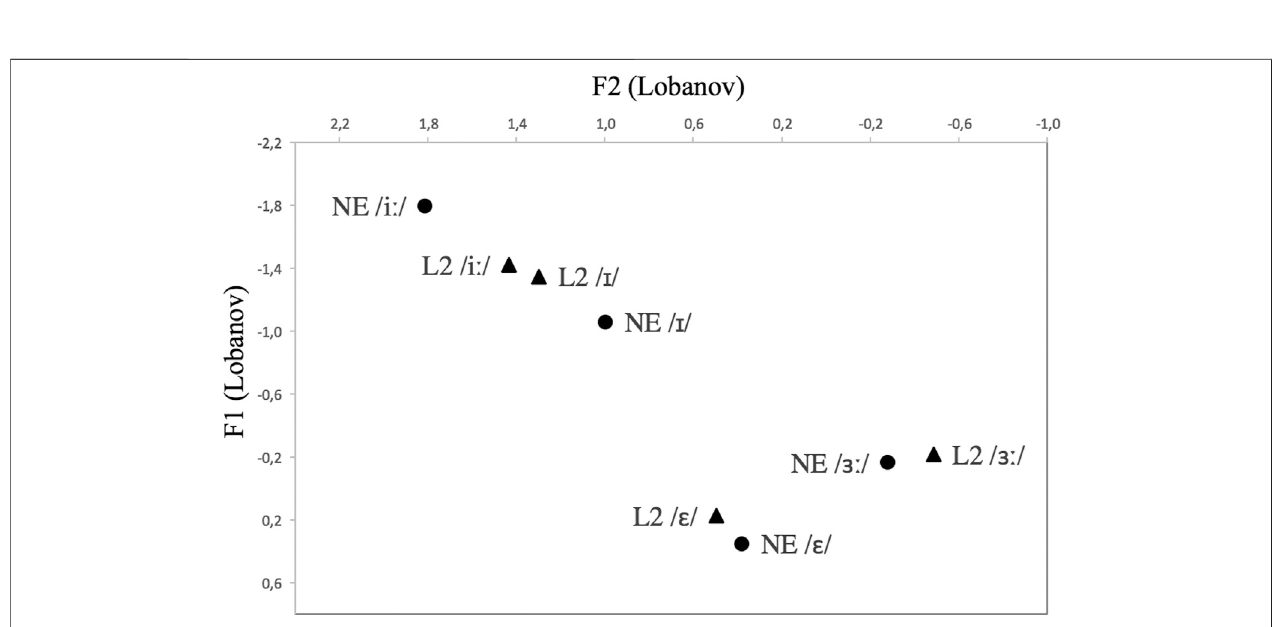
FIGURE4| Normalized F1xF2 valuesofeach ofthefourvowelsaveraged acrossthenativeEnglishspeakers (NE) and theL2Englishspeakers (L2). TheLobanov transformation has been used (see text).